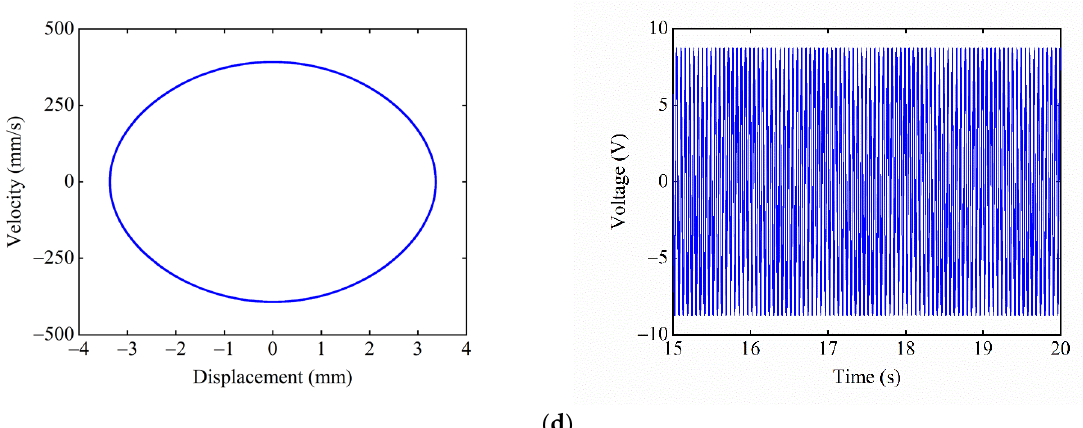
Figure 13. Phase portrait and time–voltage diagram of the system under different excitation fre- quencies: ( a ) F = 3 Hz; ( b ) F = 9 Hz; ( c ) F = 12 Hz; and ( d ) F = 18 Hz.